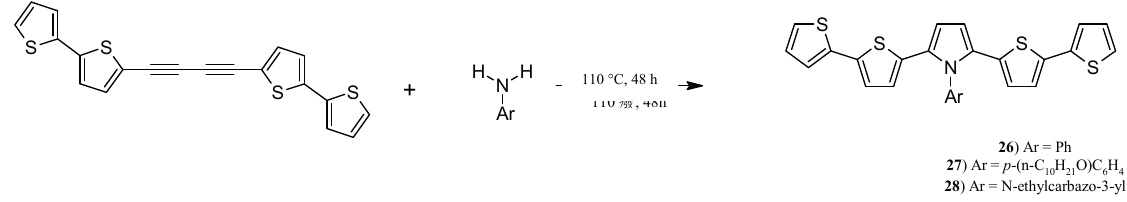
Scheme 11. Synthesis of: N -phenyl-2,5-bis(2,2'-bithiophen-5-yl)pyrrole ( 26 ); N -(p-